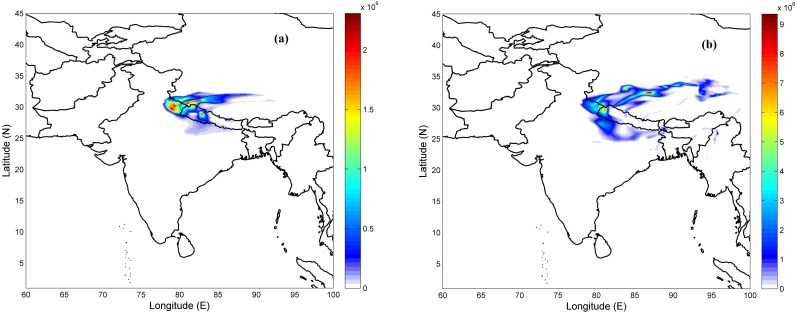
FLEXPART generated CO concentration at 500 m altitude above ground level on (A) 24 April, 2016 2100 UTC (B) 28 April, 2016 1500 UTC.